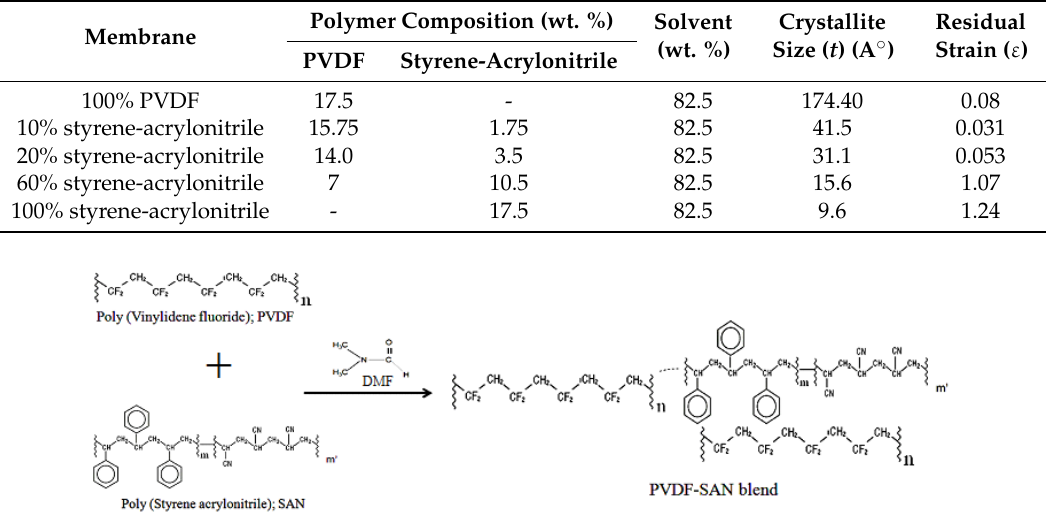
Figure 1. Scheme for modification of PVDF.